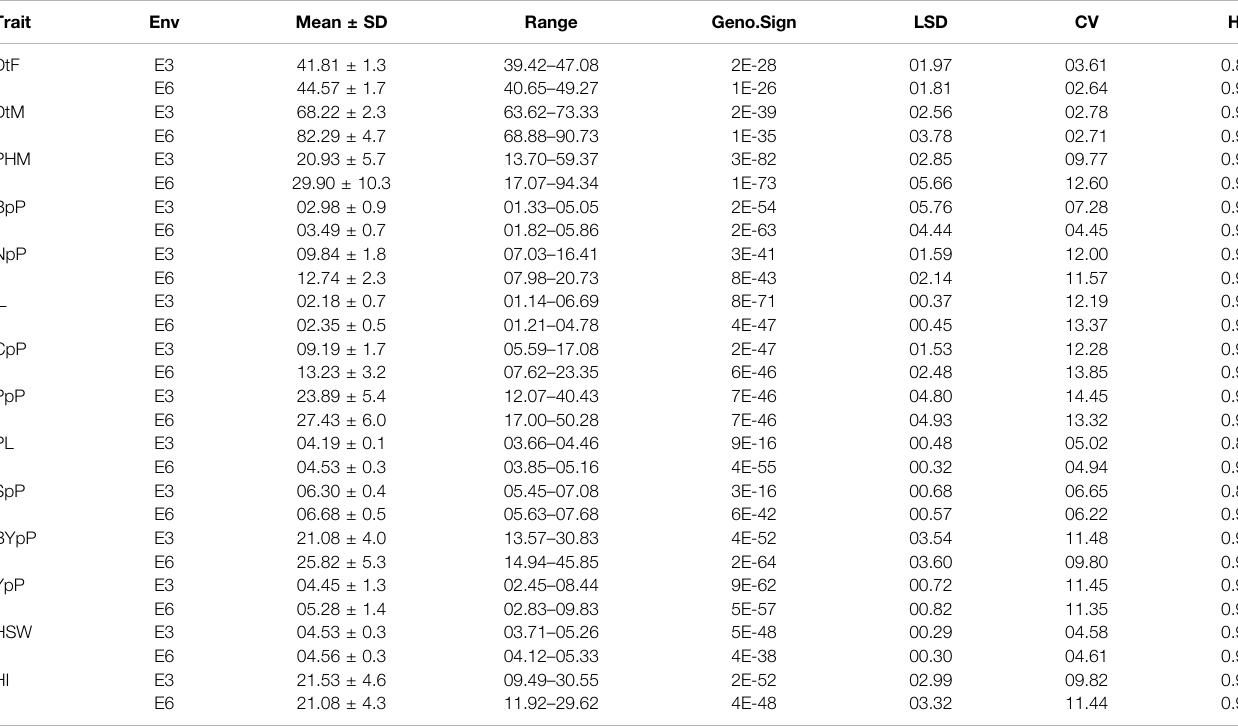
TABLE 1 | Phenotypic evaluation of 100 V. mungo genotypes for 14 traits recorded at two locations of Ludhiana and Gurdaspur as BLUPs of 2 years. Trait